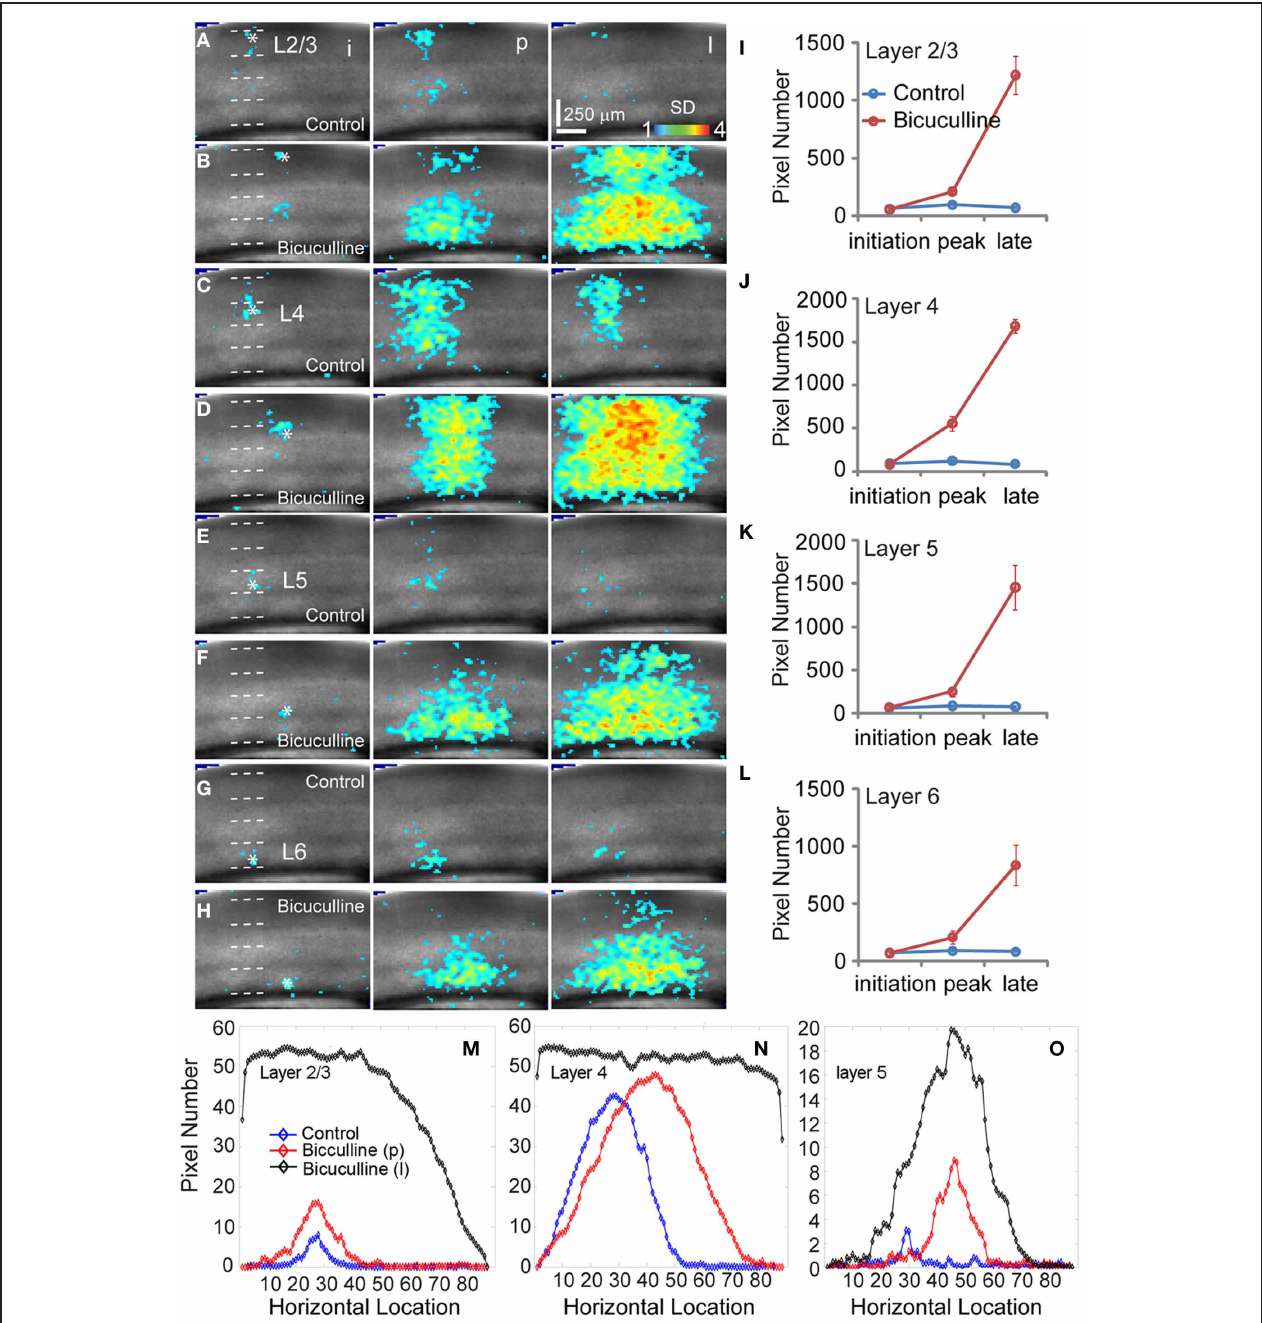
FIGURE 4 | Effects of antagonizing GABAa receptor activity with bicuculline on the spatiotemporal dynamics of local V1 circuit activity. (A , C , E, and G) show individual image frames corresponding with the initiation (i), peak (p), and late phase (l) of the VSD activation, in response to photostimulation in normal ACSF in layers 2/3, 4, and 5 of a V1 slice, respectively. In comparison, (B , D , F, and H) show activation frames of the same slice re-mapped with the addition of bicuculline in ACSF, evaluated at the three temporal phases of the VSD activation, respectively. Note that 1ms photostimulation was used for control, while 0.5ms photostimulation was used in the bicuculline presence. (I – L) Show the average number of activated pixels at the initiation, peak, and late phases of control and